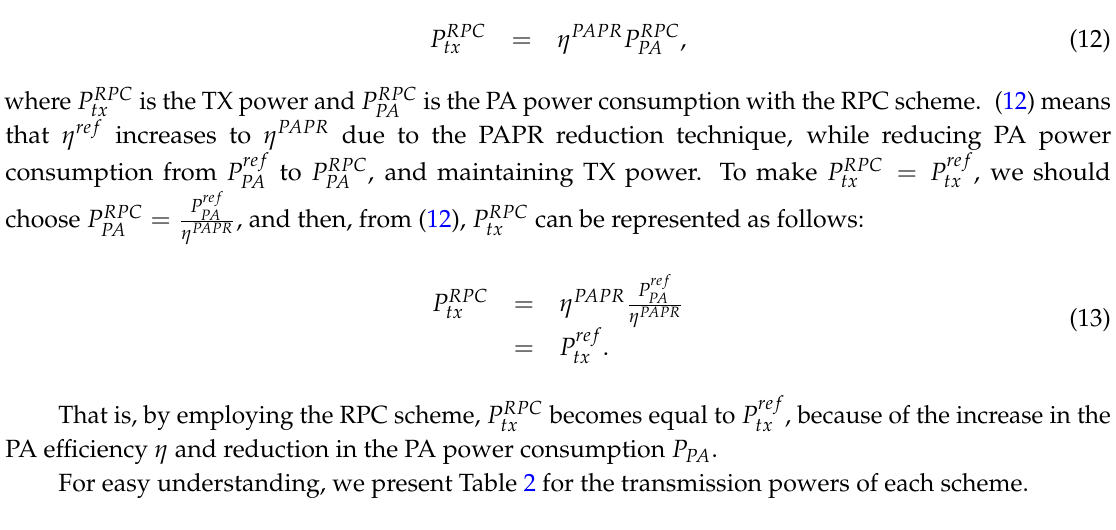
Table 2. Transmission Power for Each